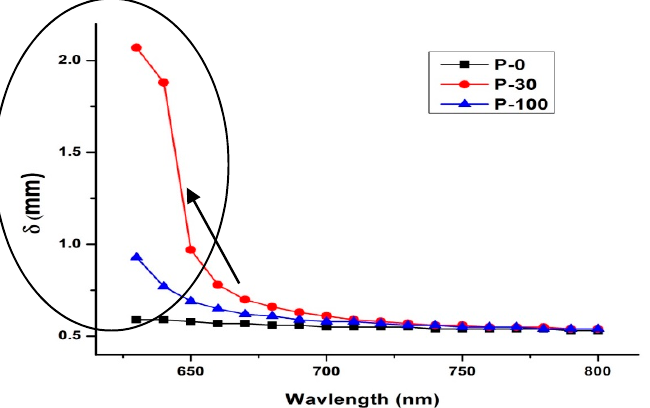
Figure 4. Penetration depth for the sample UHMWPE over the wavelength of interest from 600 nm to 800